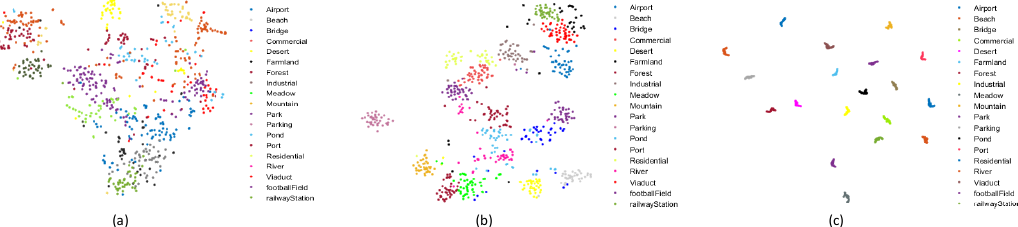
Figure 10. Two-dimensional scatterplots of SURF-based BoW features generated with t -SNE over the WHU-RS dataset. ( a ) Scatterplot of one-stage multi-scale features. ( b ) Scatterplot of features extracted and combined from four-stage learning. ( c ) Features extracted from the last fully-connected layer of BiLSTM. All points in the scatterplots are color coded by class. Zoom in for a better view.